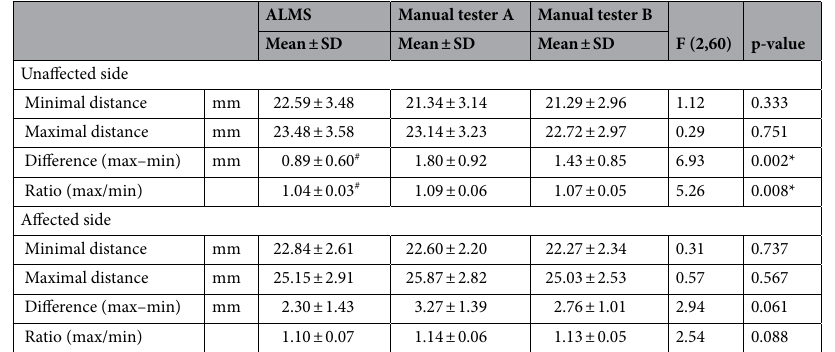
Table 4. Comparison of the mean difference of the talofibular joint distance between the ATFL origin and insertion points during the reverse anterior drawer test between the ALMS and two manual testers. ATFL anterior talofibular ligament, ALMS automated length measurement system, max maximal, min minimal, SD standard deviation. *Significant difference of talofibular joint distance at p < 0.05 (one-way ANOVA). # Significant difference between ALMS and Manual tester A at p < 0.05 (Bonferroni’s multiple comparison